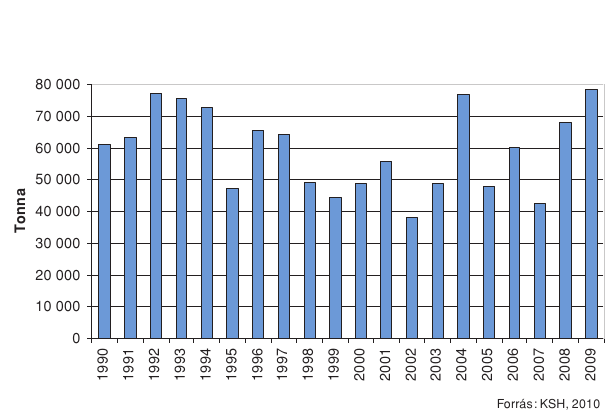
Figure 1. Quantity of sour cherry production